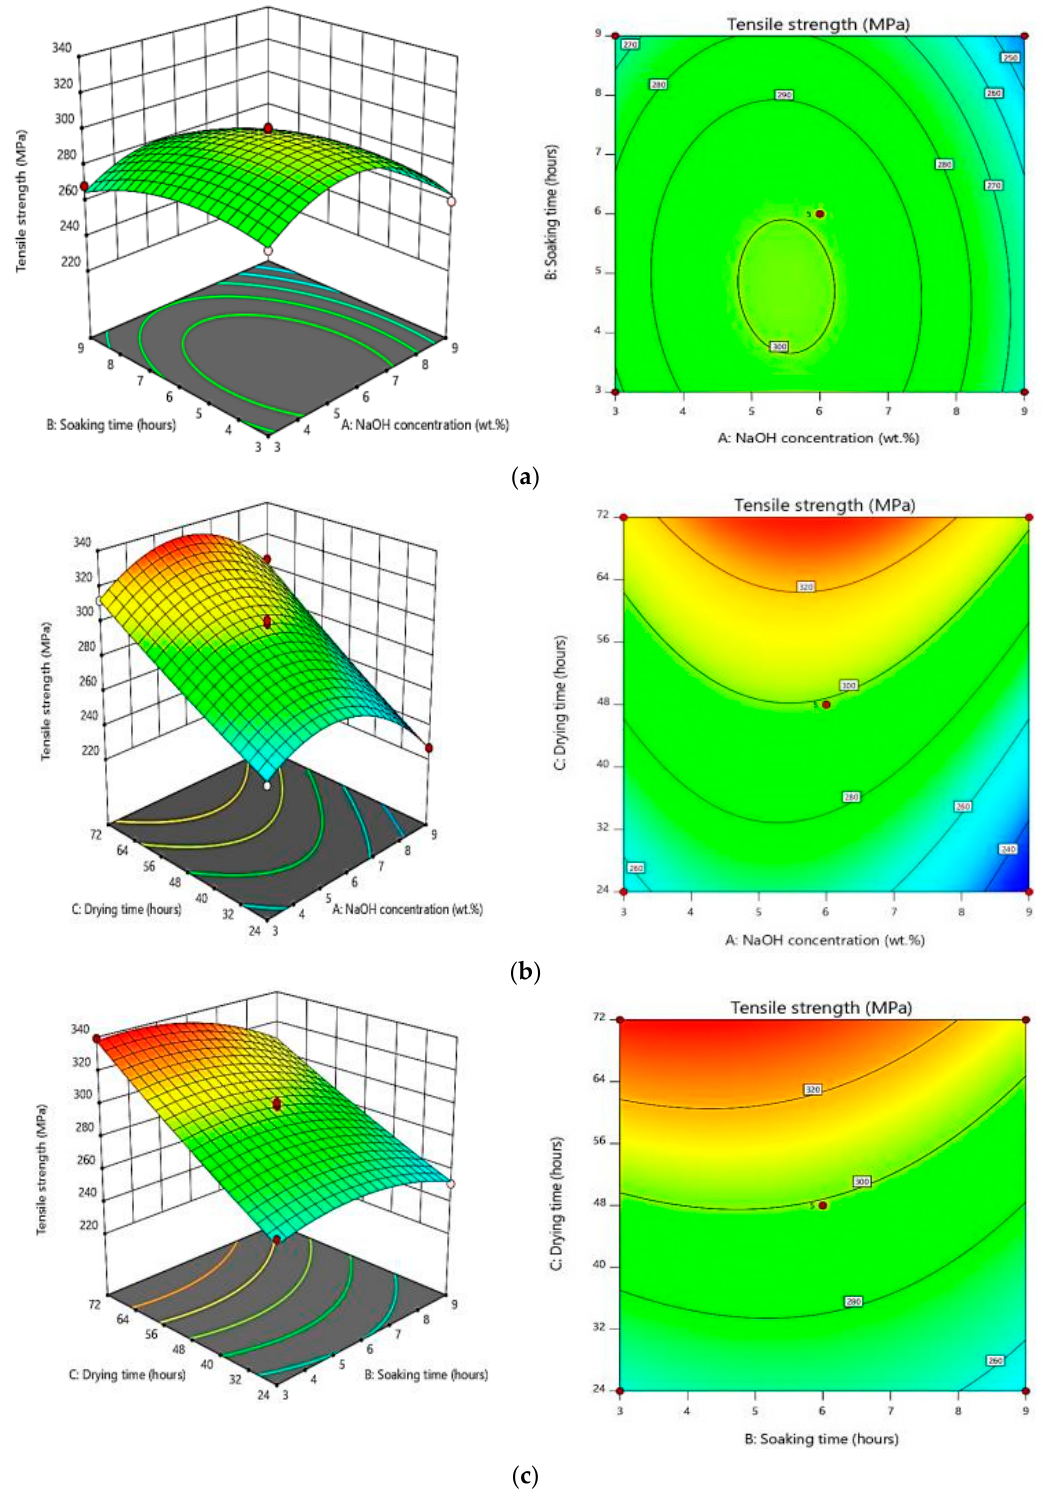
Figure 7. Typical 3D and 2D plots for the effect of ( a ) concentration versus soaking time ( b ) concentration versus drying time and ( c ) soaking time versus drying time on tensile strengths.